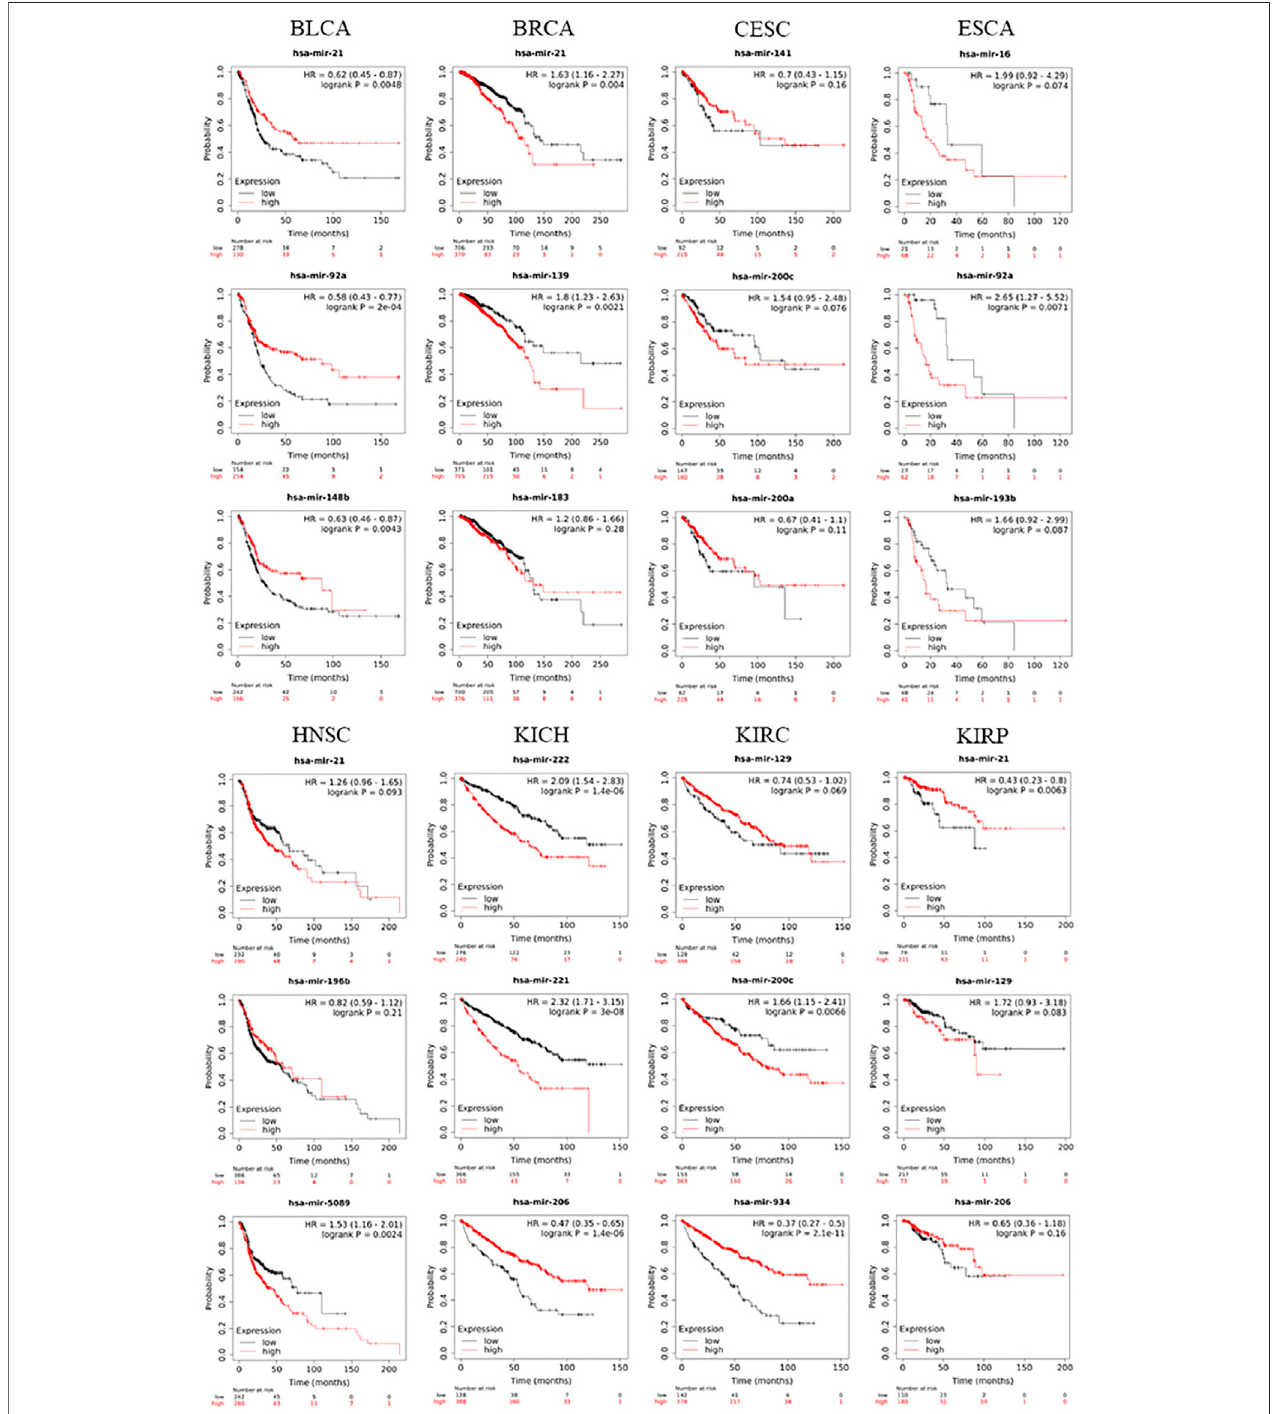
FIGURE 6 | The Kaplan-Meier survival analysis of top-3 ranked miRNAs extracted from the datasets of 20 types of cancer.